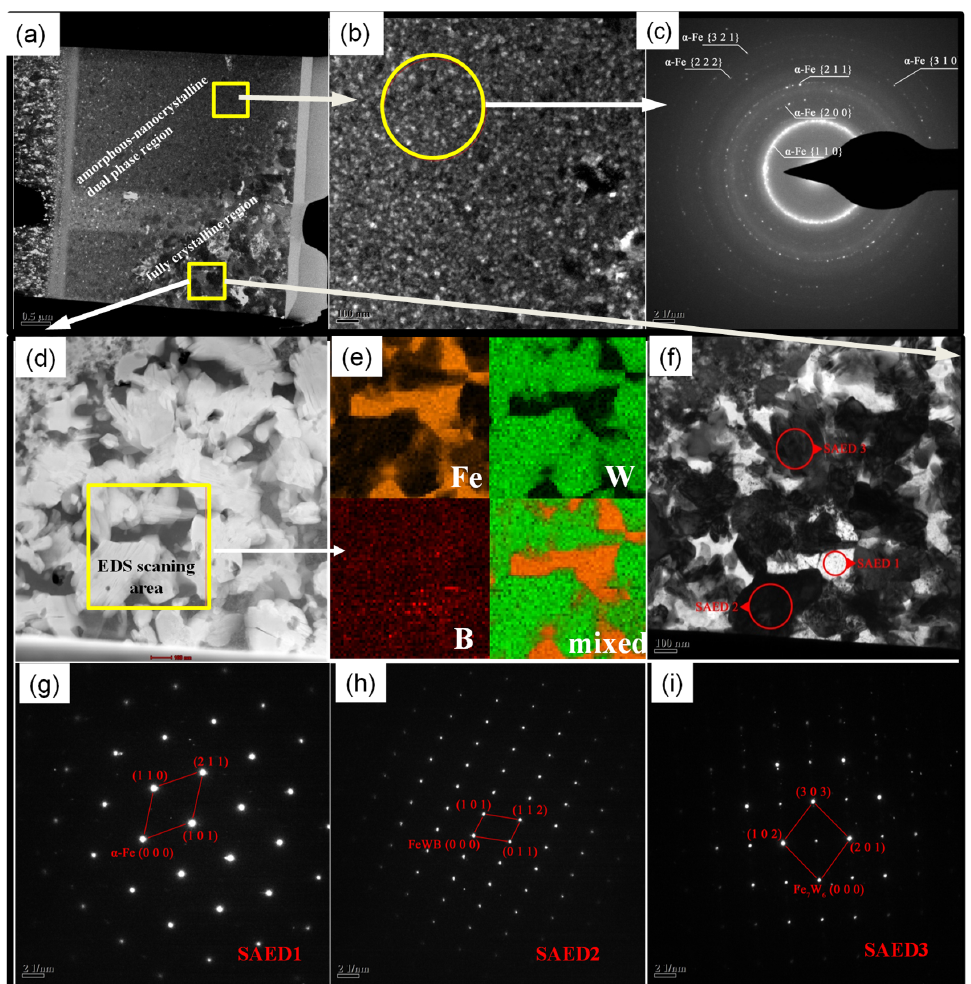
Figure 8. Microstructure of Fe-W-B amorphous powder annealed at 700 °C (TEM). ( a ) TEM sample image; ( b ) Microstructure morphology of the amorphous-nanocrystalline dual phase region; ( c ) SAED pattern of the amorphous-nanocrystalline dual phase region; ( d ) HAADF image of the fully crystallized region; ( e ) EDS microanalyses of the fully crystallized region; ( f ) HRTEM morphology of the fully crystallized region; ( g ) SAED pattern of “SAED1” within the fully crystallized region; ( h ) SAED pattern of “SAED2” within the fully crystallized region; ( i ) SAED pattern of “SAED3” within the fully crystallized region.